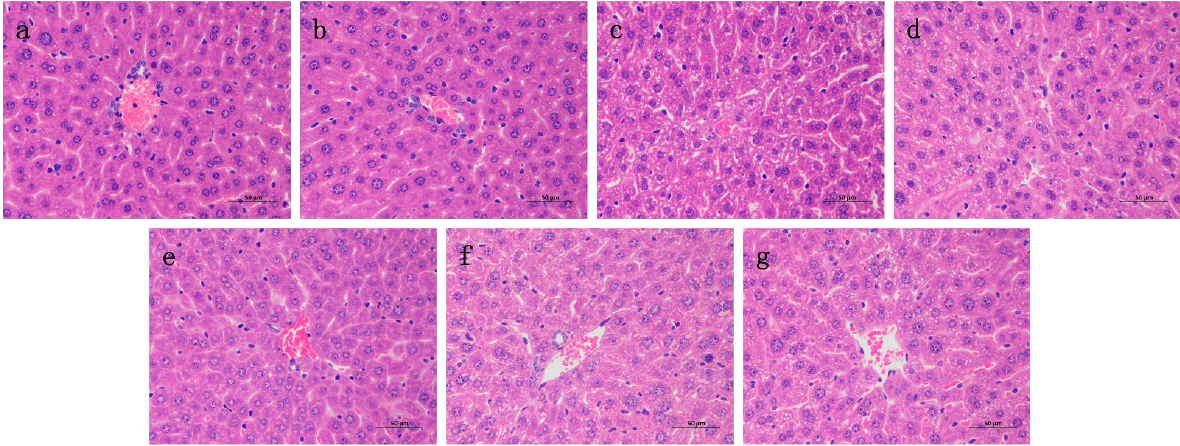
Figure 6. Histological observation of RA on CP-induced ALI in mice and the differences between groups were observed using H&E staining at 400 × magnification. Pathological examination of control group ( a ) mice; ( b ) optimal therapeutic dose of RA (20 mg/kg) given to mice; ( c ) CP (20 mg/kg) challenged mice; ( d – f ) RA (5, 10, 20 mg/kg) treated CP-challenged mice; ( g ) mice were challenged with CP of the DEX (4 mg/kg) control treatment drug.